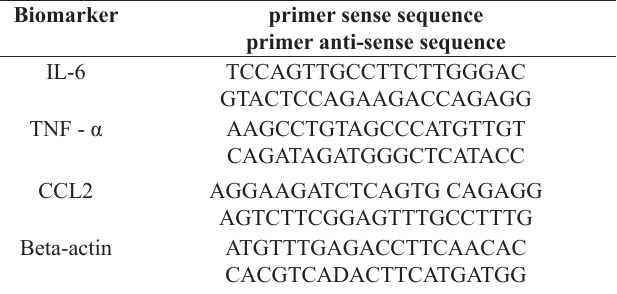
Table 1. Primers used for the analysis of inflammatory biomarkers.